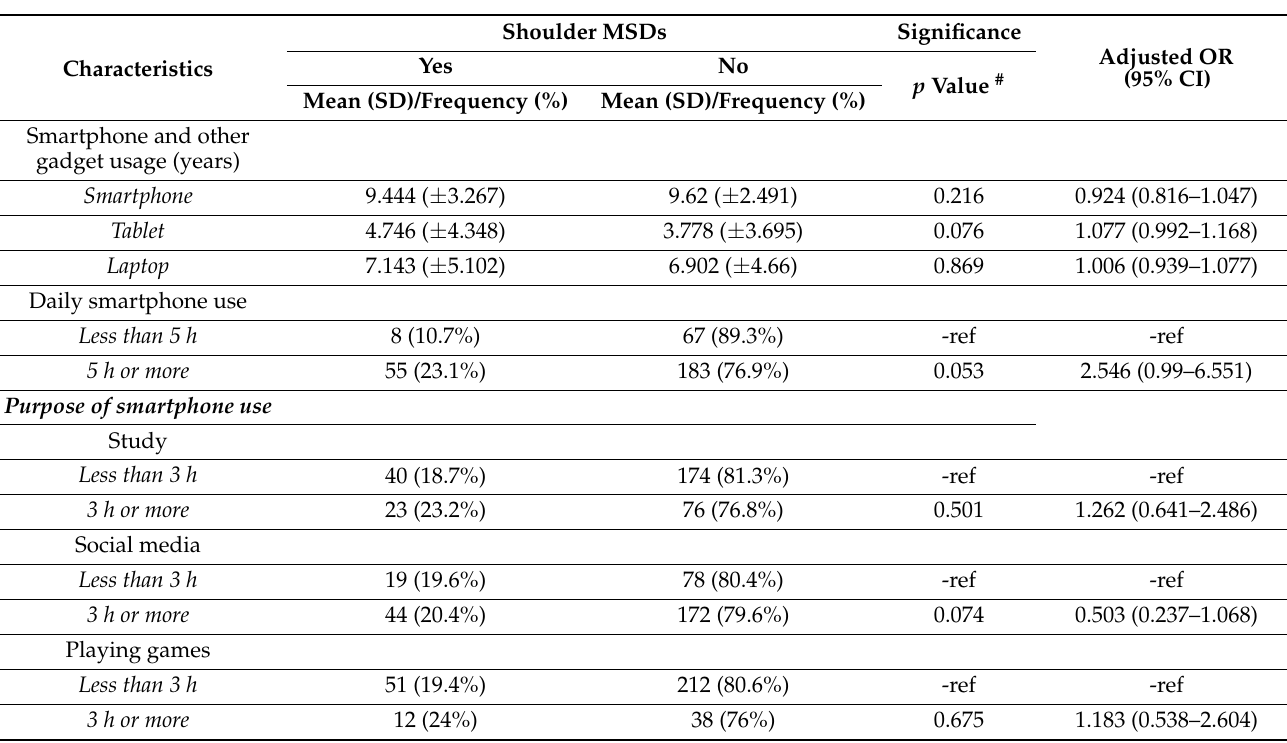
Table 4. Association between shoulder MSDs and smartphone